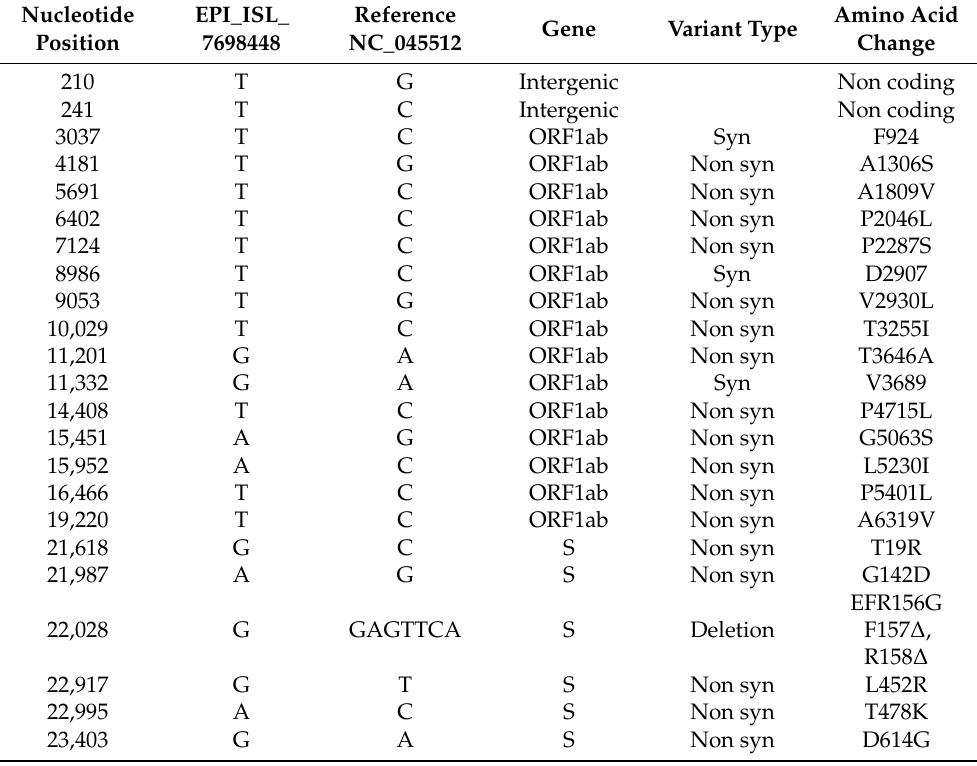
Table 5. Nucleotide mutations and amino acid substitutions in the B.1.617.2+AY.43 strain